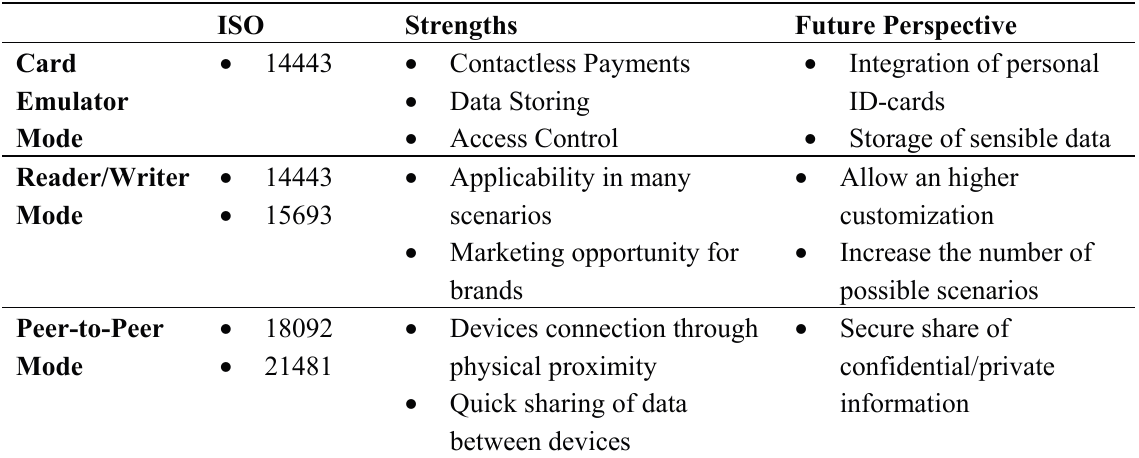
Table 2. Benefits and possible future perspectives NFC three main functions (source: authors’ elaboration based on